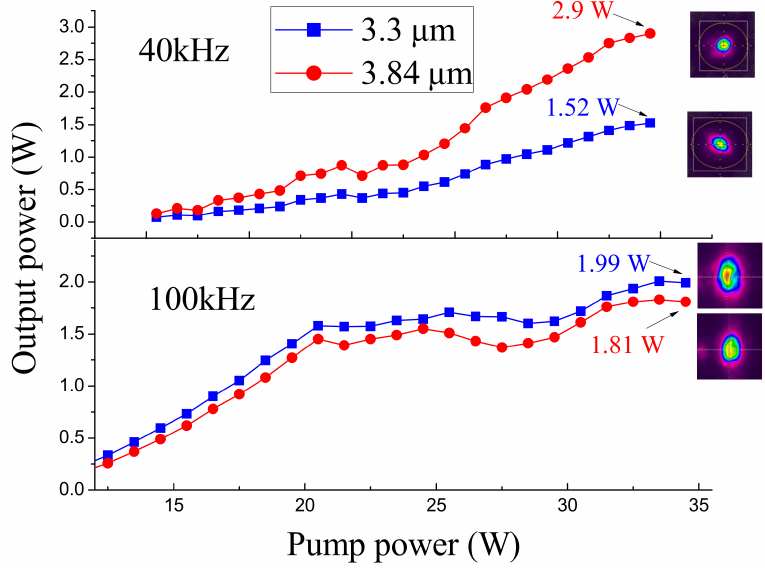
Figure 5. Power curve and beam qualities at different repetition rates.